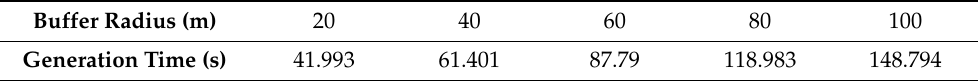
Table 4. The radii and generation times of the buffers with a sphere grid level of 19. Buffer Radius (m)